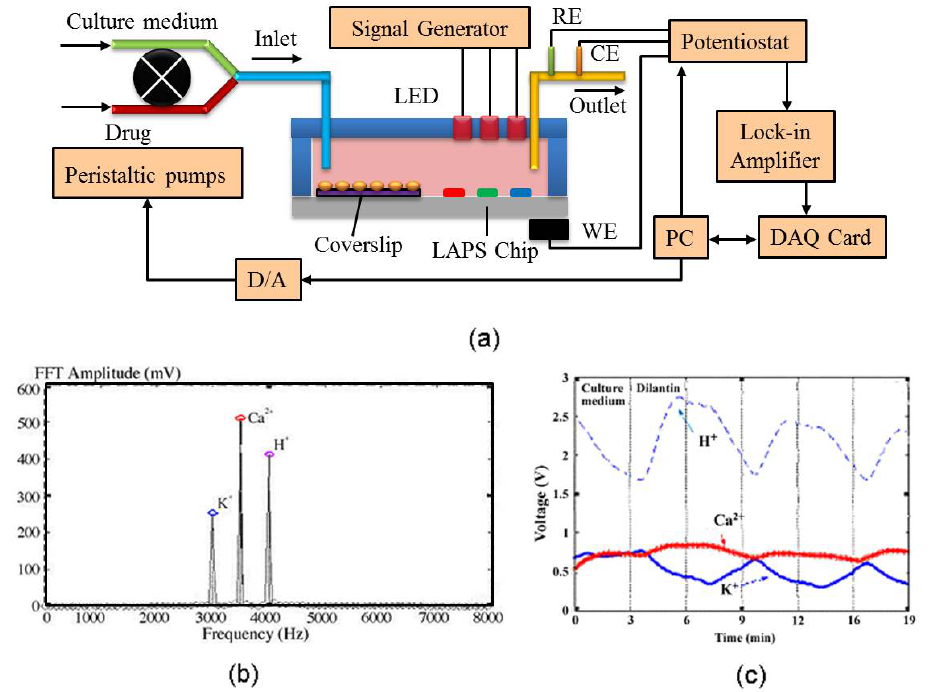
Figure 23. Multianalyte microphysiometer studies based on LAPS. ( a ) The schematic drawing of the multiparameter-LAPS system to different extracellular ions (H + , K + , and Ca 2+